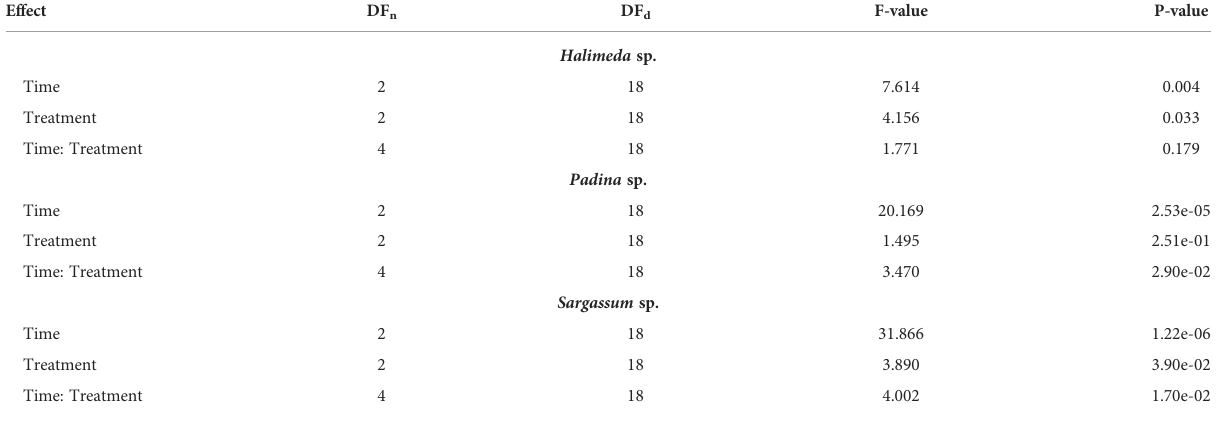
TABLE 2 MTT reduction assay ANOVA model